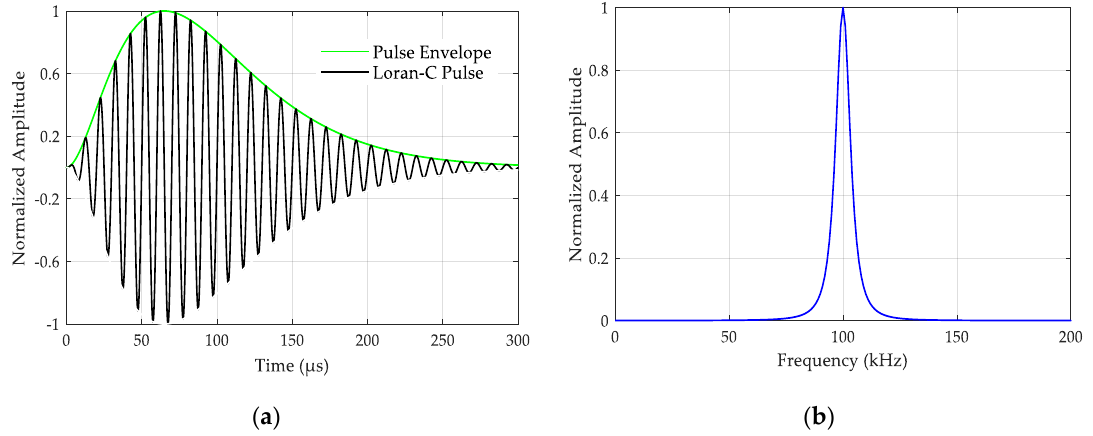
Figure 1. The characteristics of a single Loran-C signal for a positive phase-coded pulse: ( a ) Loran-C pulse waveform; ( b ) Loran-C pulse spectrum.